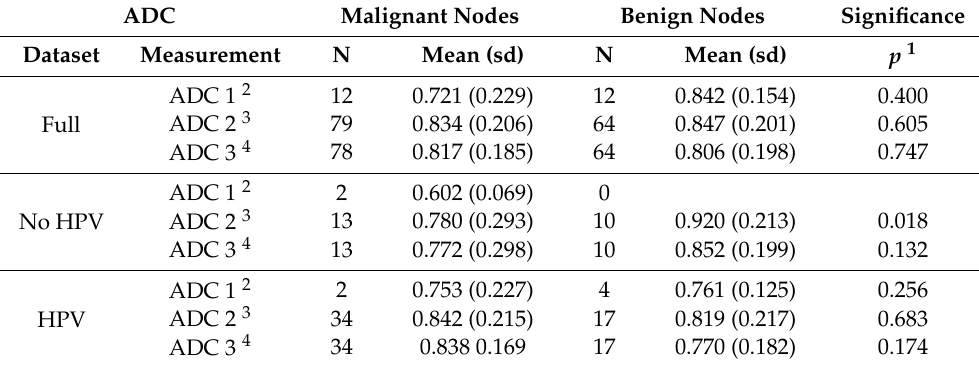
Table 3. Difference in mean ADC between cytologically malignant and benign PET-positive nodes. ADC Malignant Nodes Benign Nodes Significance